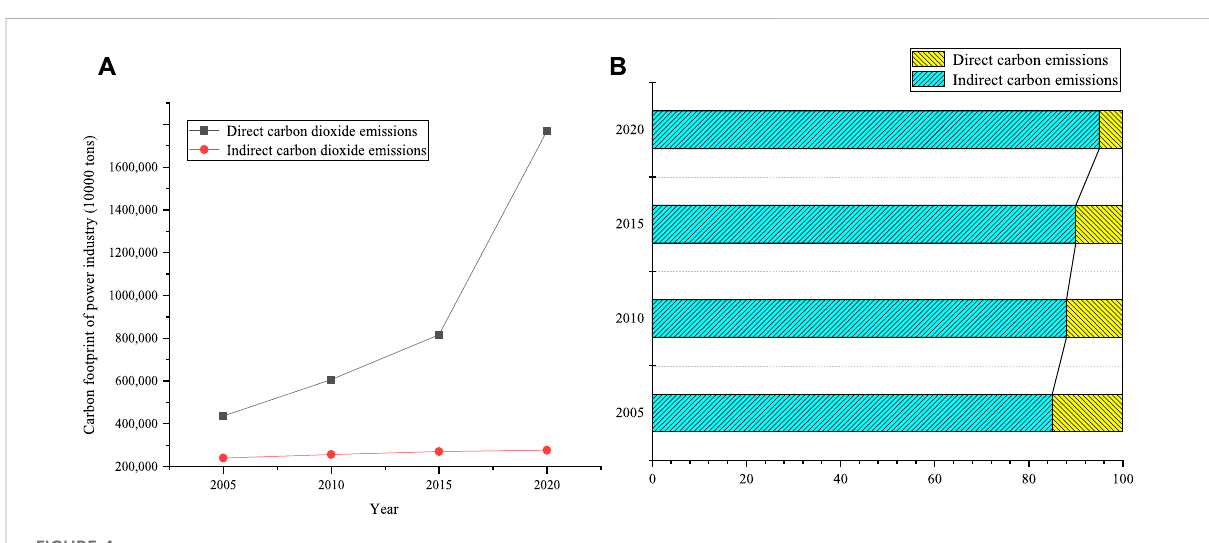
FIGURE 4 Direct and indirect CDEs and emission ratio of power enterprises. (A) Direct and indirect CDEs from power enterprises; (B) Proportion of direct and indirect CDEs in power